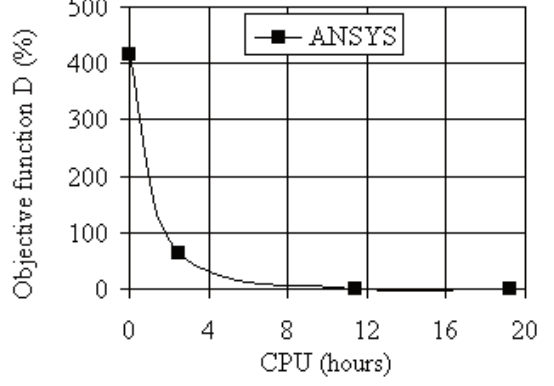
Fig. 6. Computation time.